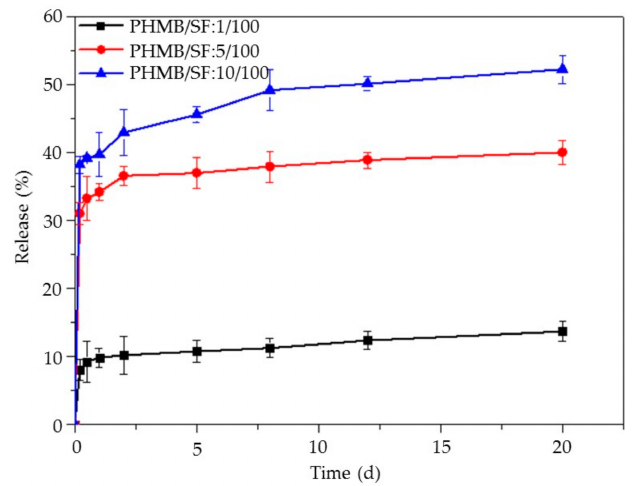
Figure 5. Release of PHMB from PHMB / SF sponges upon immersing the sponges in PBS at 37 ◦ C. PHMB / SF ratios: 1 / 100, 5 / 100, 10 / 100.